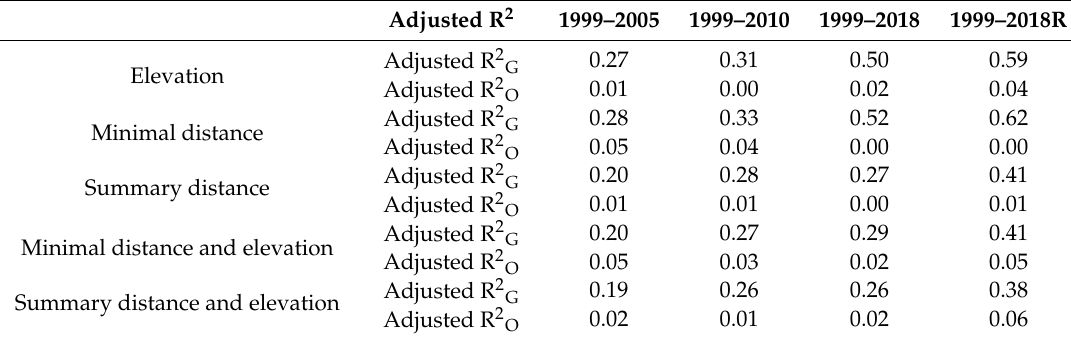
Table 2. Comparison in adjusted R 2 of geographically weighted regression (GWR) and ordinary least squares (OLS) models.